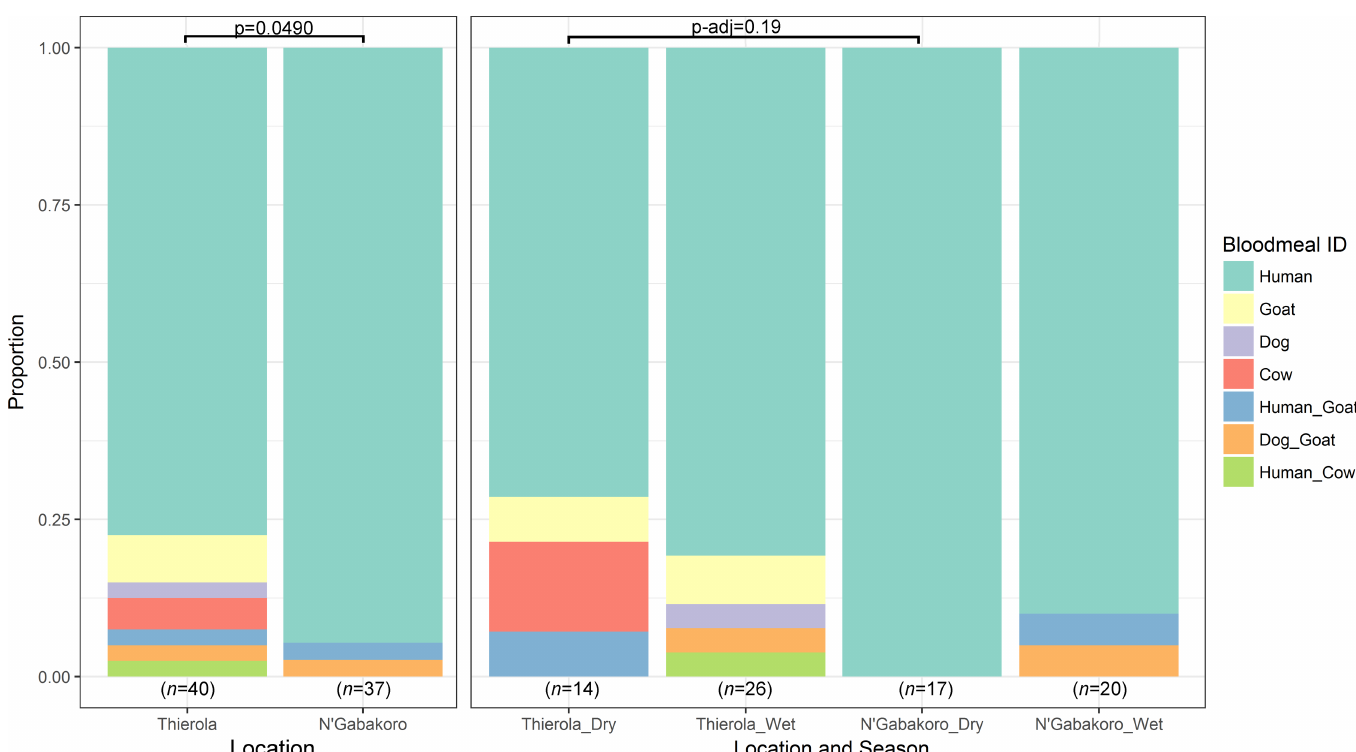
Fig 5. Host-choice preference determined via cytochrome B PCR. Significant difference between "human" and "other" bloodmeals for each location and season determined via a contingency table and two-tailed Fisher’s exact test. p -values for the season and location comparison were adjusted for multiple comparisons. Bloodmeals of mixed origin are separated by an underscore, i.e. “Human_Goat” had amplification of bands corresponding to sizes of both human and goat blood.